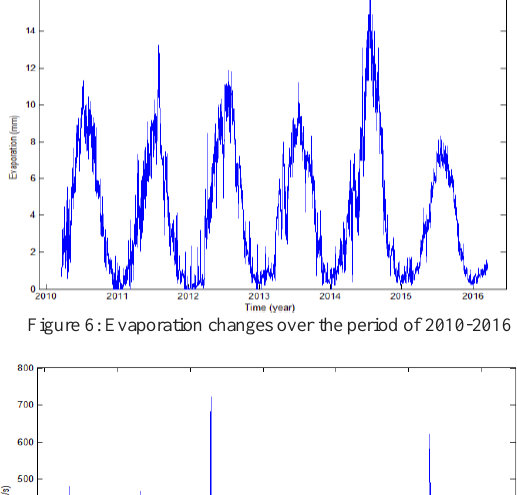
Figure 6: Evaporation changes over the period of 2010-2016